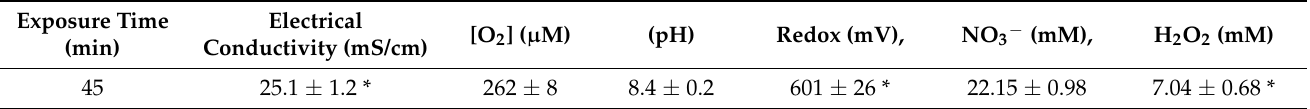
Table 1. Physicochemical characteristics of PTS obtained from 10% NaCl solution after 45 min of exposure.